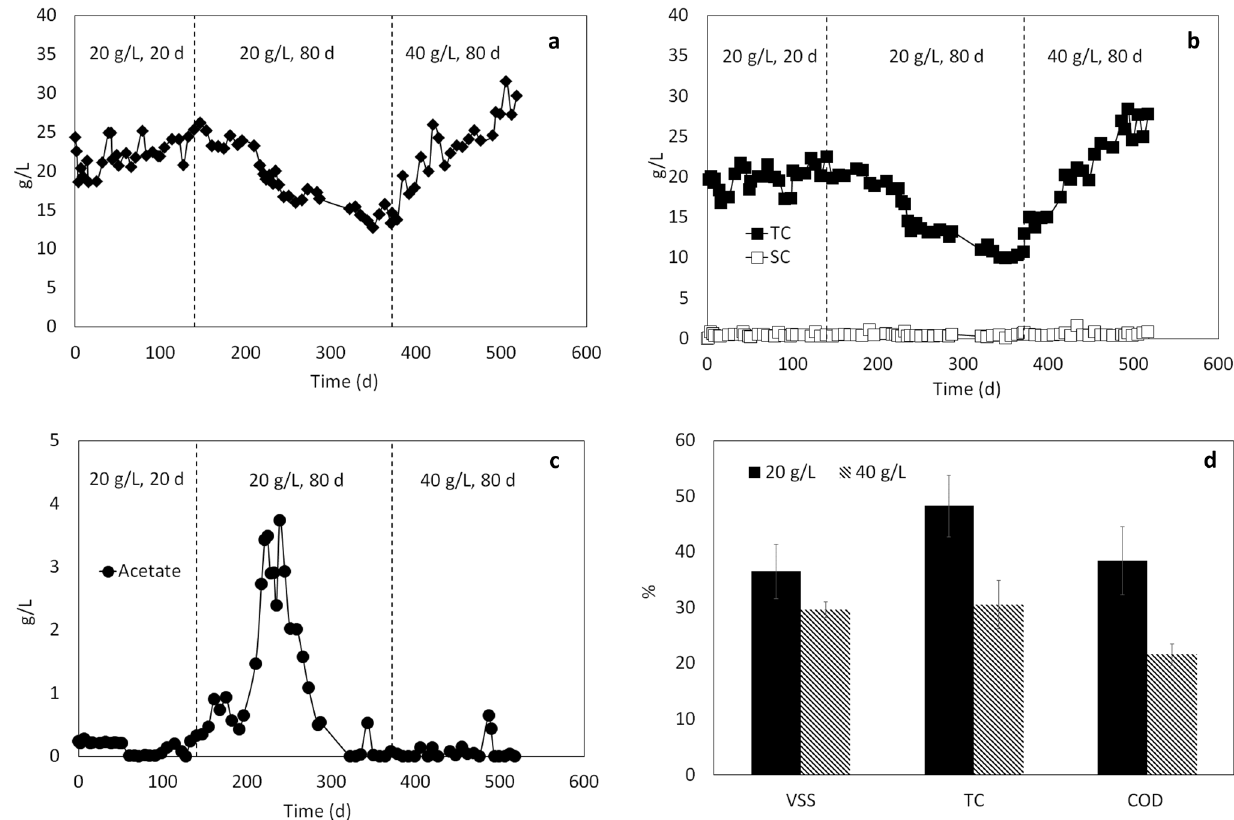
Fig. 4 Experimental data for Run C. a VSS; b TC and SC; c liquid-phase products; d average removal at steady state for residence time 80